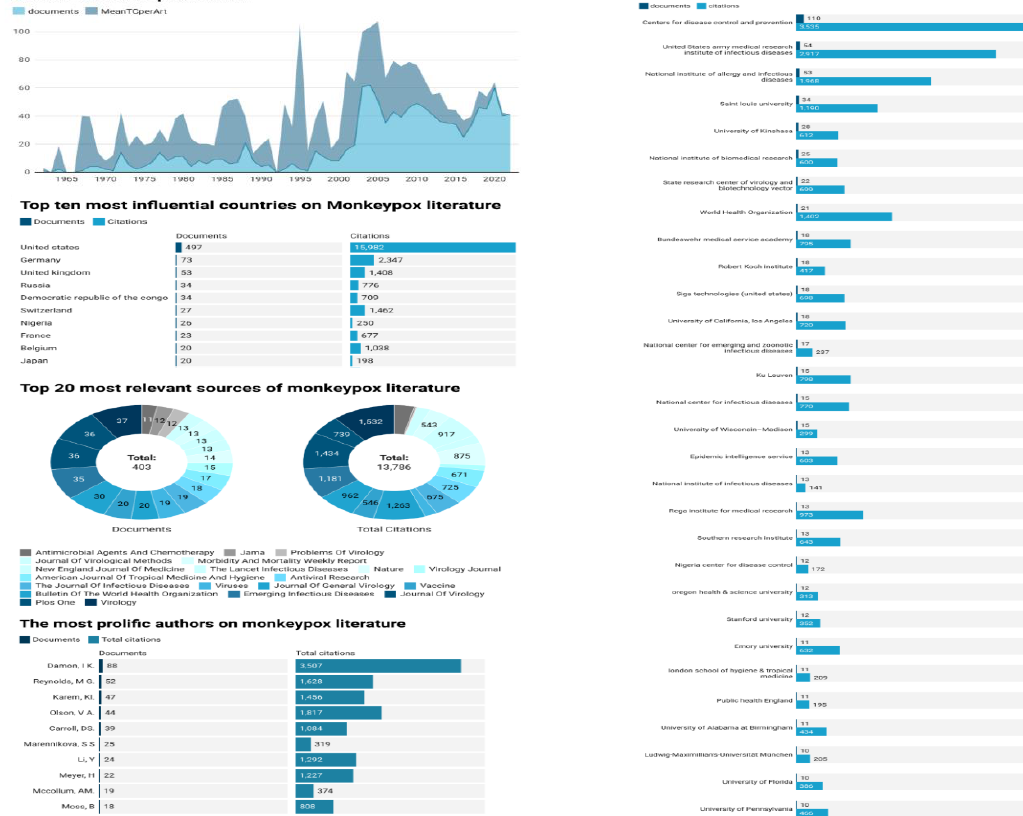
Figure 1 (a) Annual scientific production (b) Top 10 most influential countries (c) Top 20 most relevant source (d) most relevant author affiliation (e) Most prolific authors